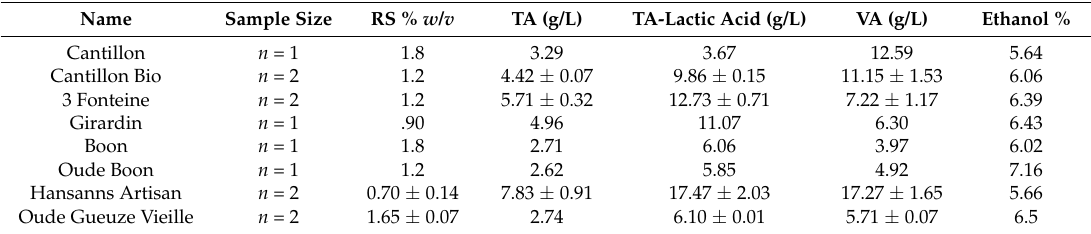
Table 3. Chemical measurements of lambic beer